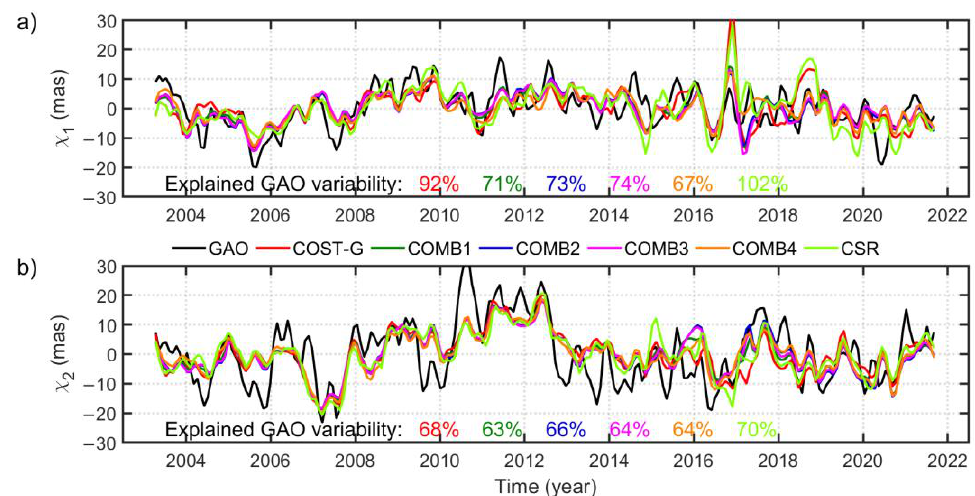
Figure 10. Time series of non-seasonal χ 1 ( a ) and χ 2 ( b ) components of GAO and gravimetric excitation determined from a single GRACE/GRACE-FO solution (CSR), combined GRACE/GRACE-FO solution (COST-G), and the four combined solutions developed in this study (COMB1, COMB2, COMB3, and COMB4). The plots include values of explained GAO variability, which was computed as a relation between STD of gravimetric excitation and STD of GAO (STD gravimetric excitation /STD GAO ) given in %.